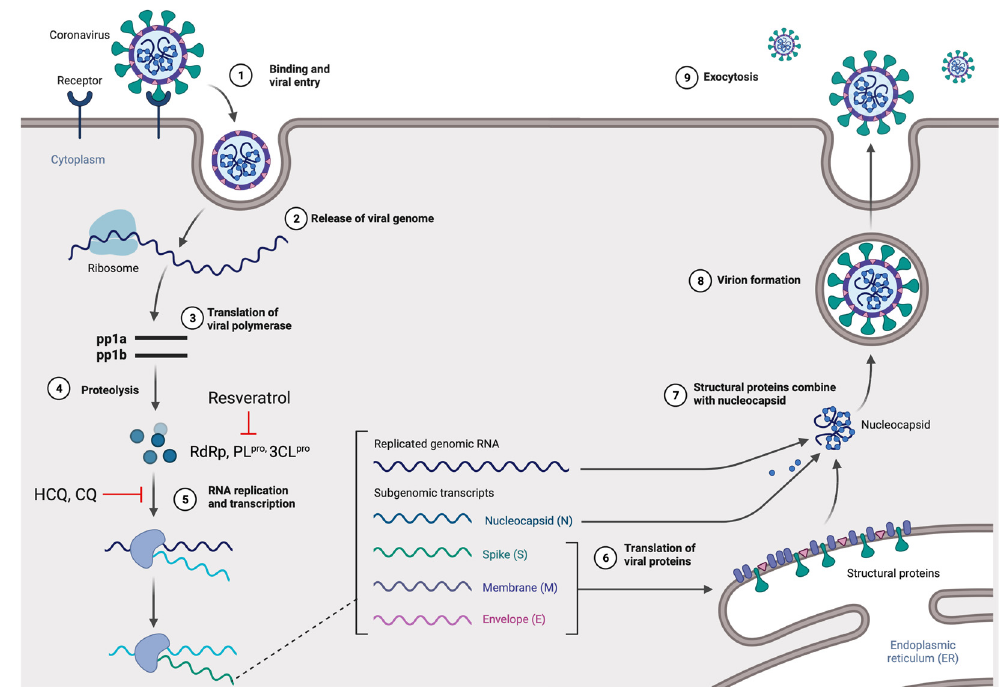
Figure 2. The life cycle of SARS-CoV-2 in the host cells. The S glycoprotein of the virion binds to the cellular receptor angiotensin-converting enzyme (ACE2) and enters the target cell through an endosomal pathway. Following the entry, the viral RNA is translated to produce pp1a and pp1ab, which are then cleaved by the proteases (RdRp, PL pro , and 3CL pro ). During the RNA replication and transcription, genomic RNA and structural proteins (N, M, E, and S) were produced. Following the production of SARS-CoV-2 structural proteins, nucleocapsids are assembled in the cytoplasm and followed by budding into the lumen of the endoplasmic reticulum (ER)–Golgi intermediate compartments. Virions are then released from the infected cell through exocytosis. Red lines indicate possible antiviral mechanisms of bioactive compounds (figure created with Biorender.com).